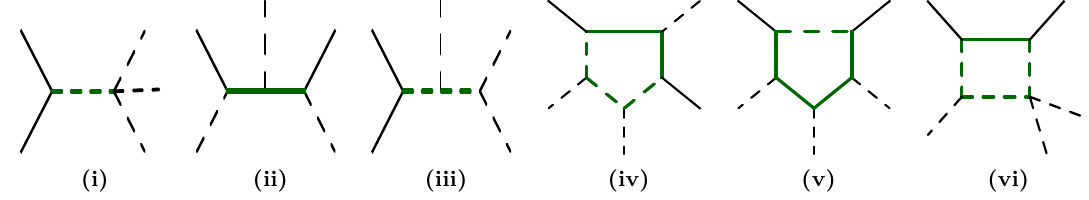
Figure 5 . Tree- (i)–(iii) and one-loop-level (iv)–(vii) diagrams built of Lorentz invariant renormal- izable interactions of the UV theory that lead to effective operators of ψ 2 φ 3 class.